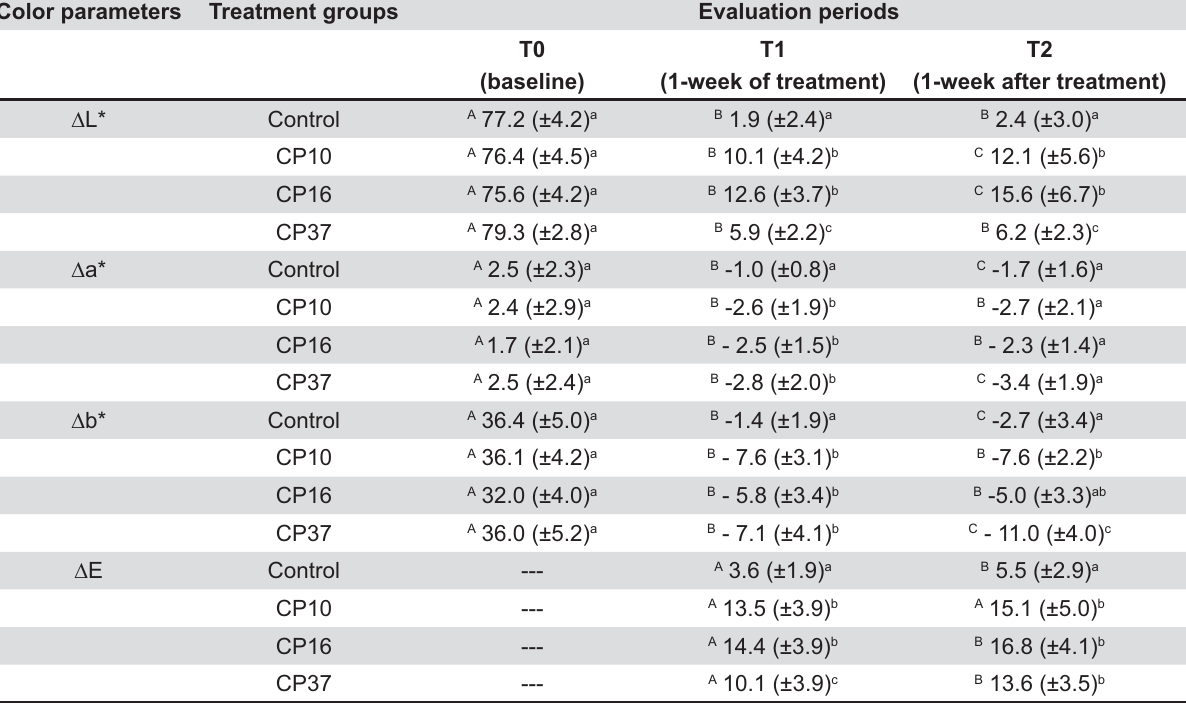
Table 2- Tooth color parameter means and standard deviations (±SD) for the different treatment groups according to the evaluation